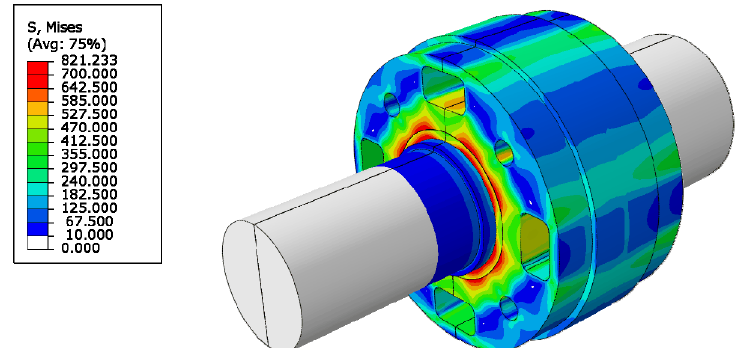
Figure 5. FE results of the interference fit.